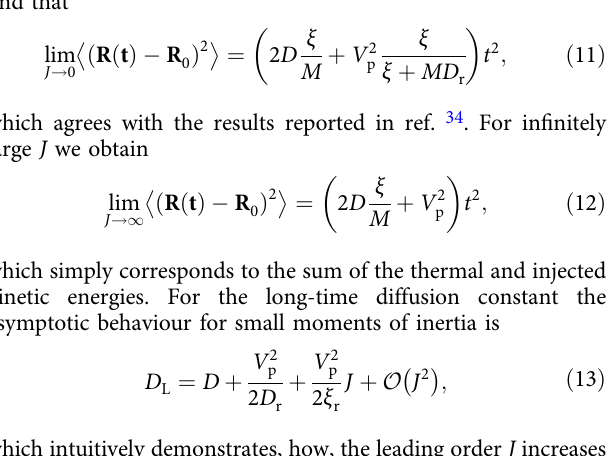
Fig. 3 are consistent. Some deviations above the statistical error are visible, in particular for the tug particle (dotted line in Fig. 4c), due to over fi tting the parameters, when the delay function is not t, which minimises the total mean squared error for the curves from Figs. 3 and 4. All curves obtained from this agree with the measurements within the statistical error (see dashed magenta lines in Fig. 4a – d).